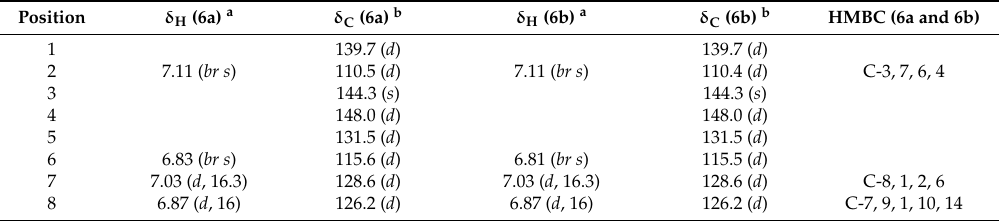
Table 3. Nuclear Magnetic Resonance shifts of isolated molecule 6 from black spruce bark hot water extract 1 H and 13 C shifts and Heteronuclear Multiple Bond Correlation (HMBC) of 6a and 6b molecules.